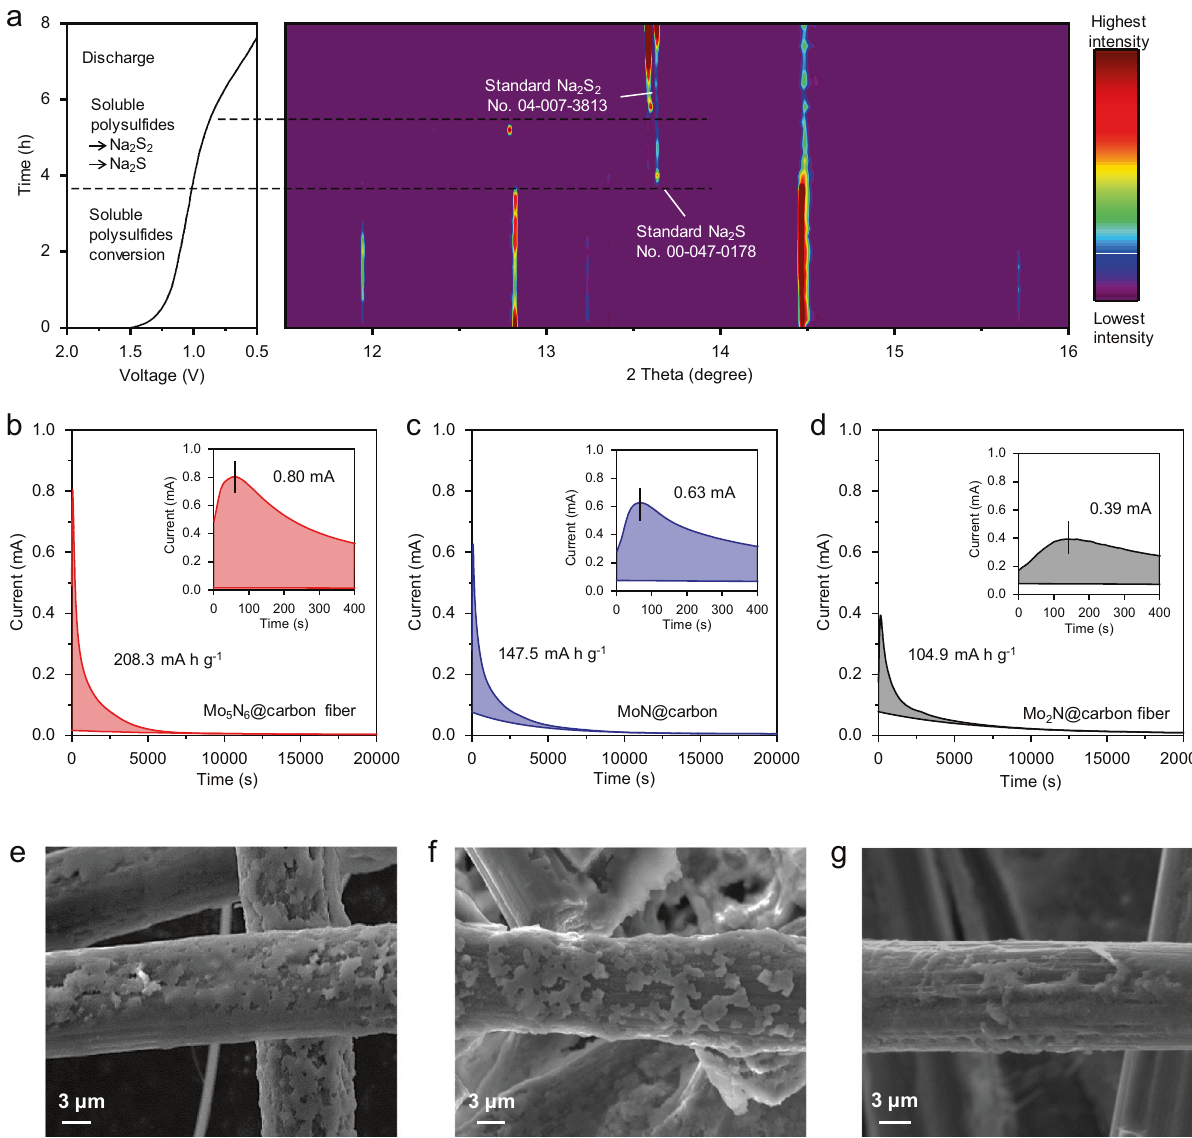
Fig. 4 Kinetic investigations of Na 2 S electrodeposition. a Galvanostatic discharge curve and corresponding in-situ synchrotron XRD patterns for S/ Mo 5 N 6 electrode. b – d Potentiostatic discharge curves for electrodeposition rate measurements on the three materials. Insets are the fi rst 400 s in the electrodeposition. e – g SEM images of electrodeposition tests on the three cathode